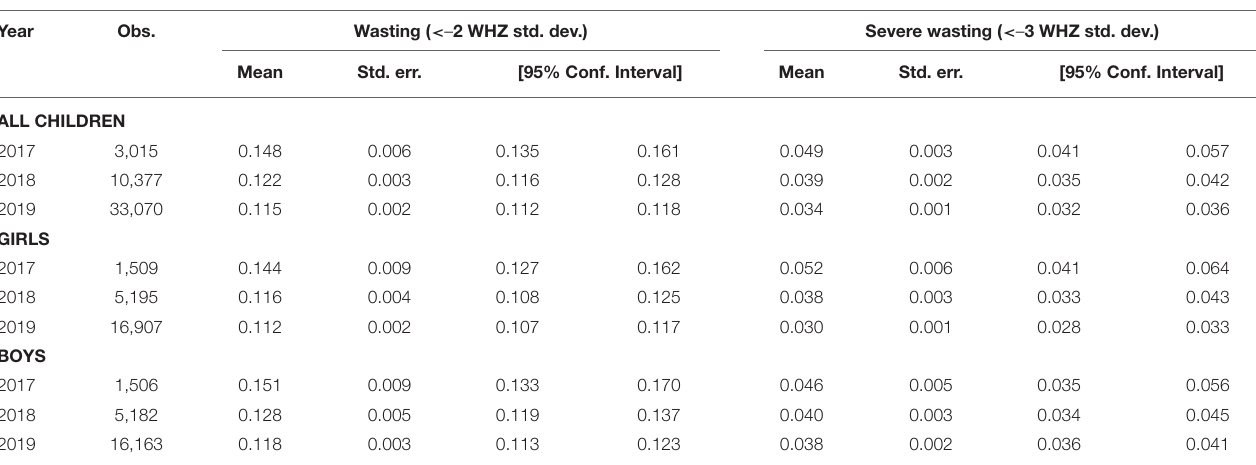
TABLE 3 | Prevalence of wasting and severe wasting in program’s